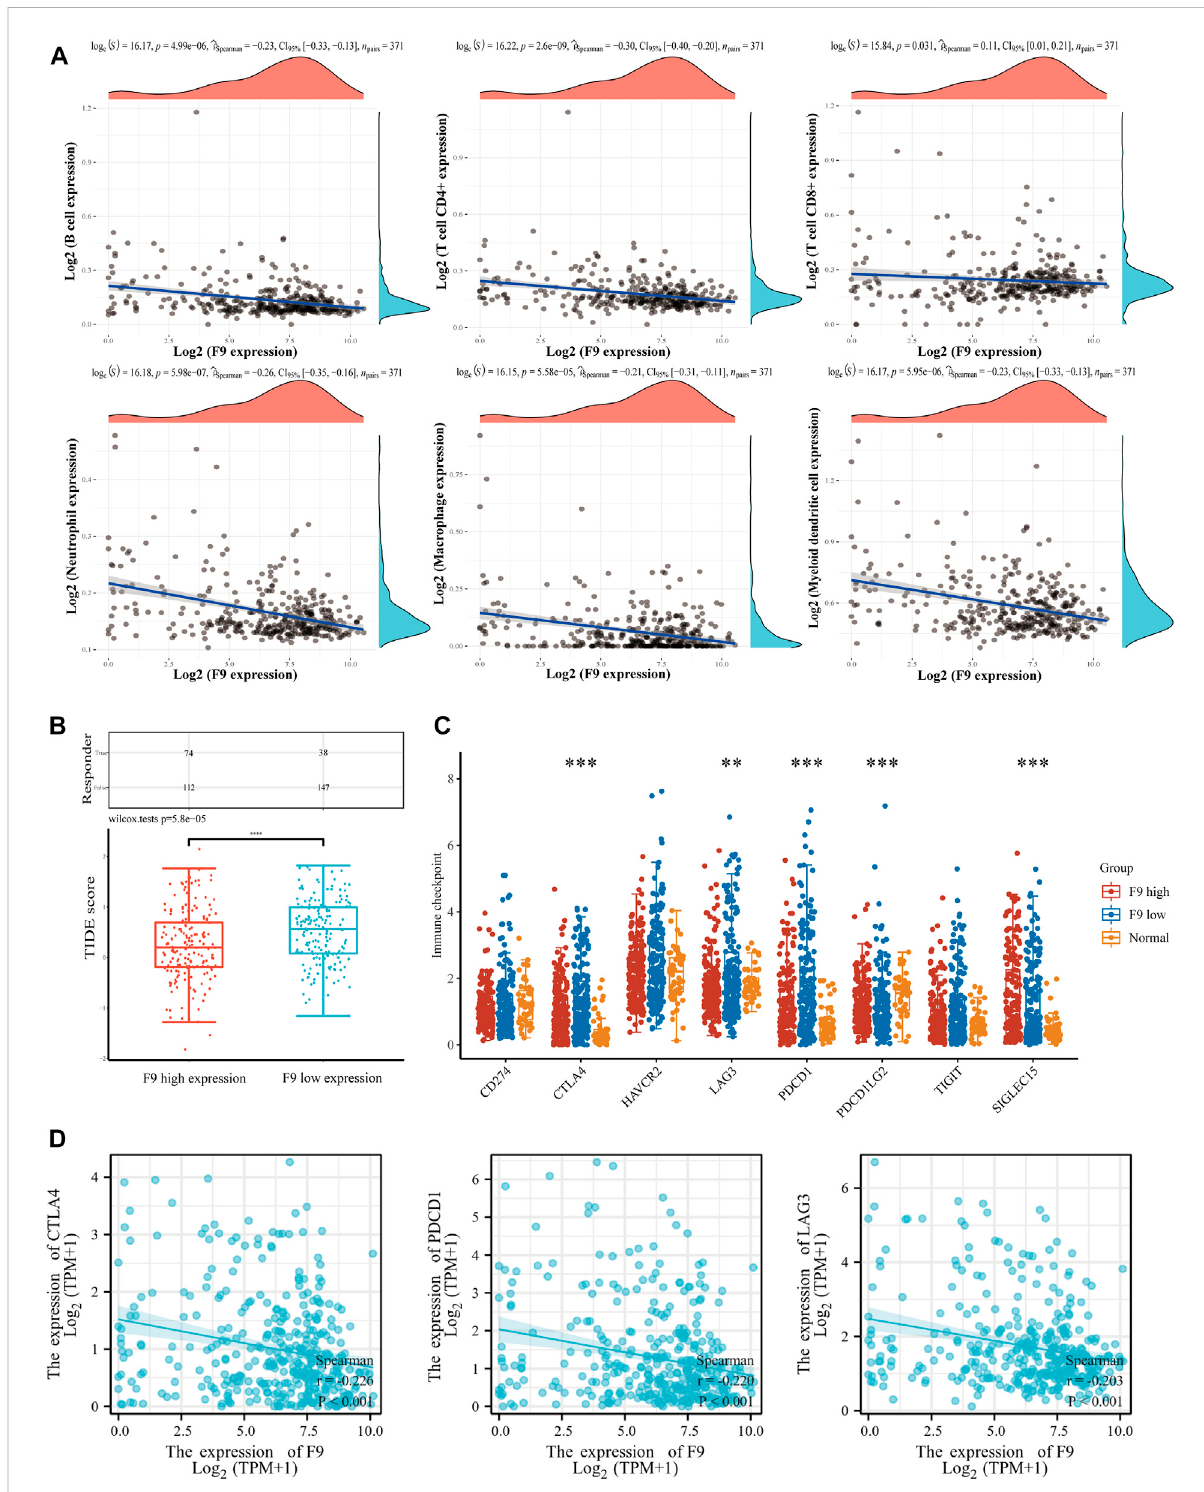
FIGURE 11 The correlation analysis between F9 and immune cell in fi ltration in HCC. (A) The correlation between F9 and immunocyte in fi ltration. (B) The distribution of immune response scores in F9 -high and F9 -low groups in the prediction results. The F9 -low group was signi fi cantly higher than the F9 -high-expression group. (C) The expressiondistributionofimmunecheckpoints gene in F9 -high and F9 -low tissues. (D) The correlation between CTLA4 , PD1 , LAG3 and F9 in